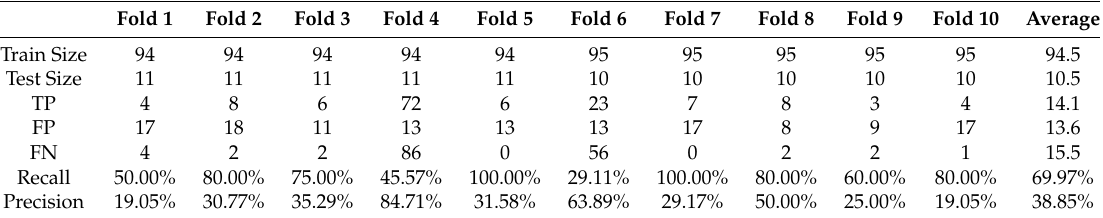
Table A9. The Results of Experiment 9: Augment 50% of dataset containing images with and without dent (Dataset 5), with a larger number of epochs.